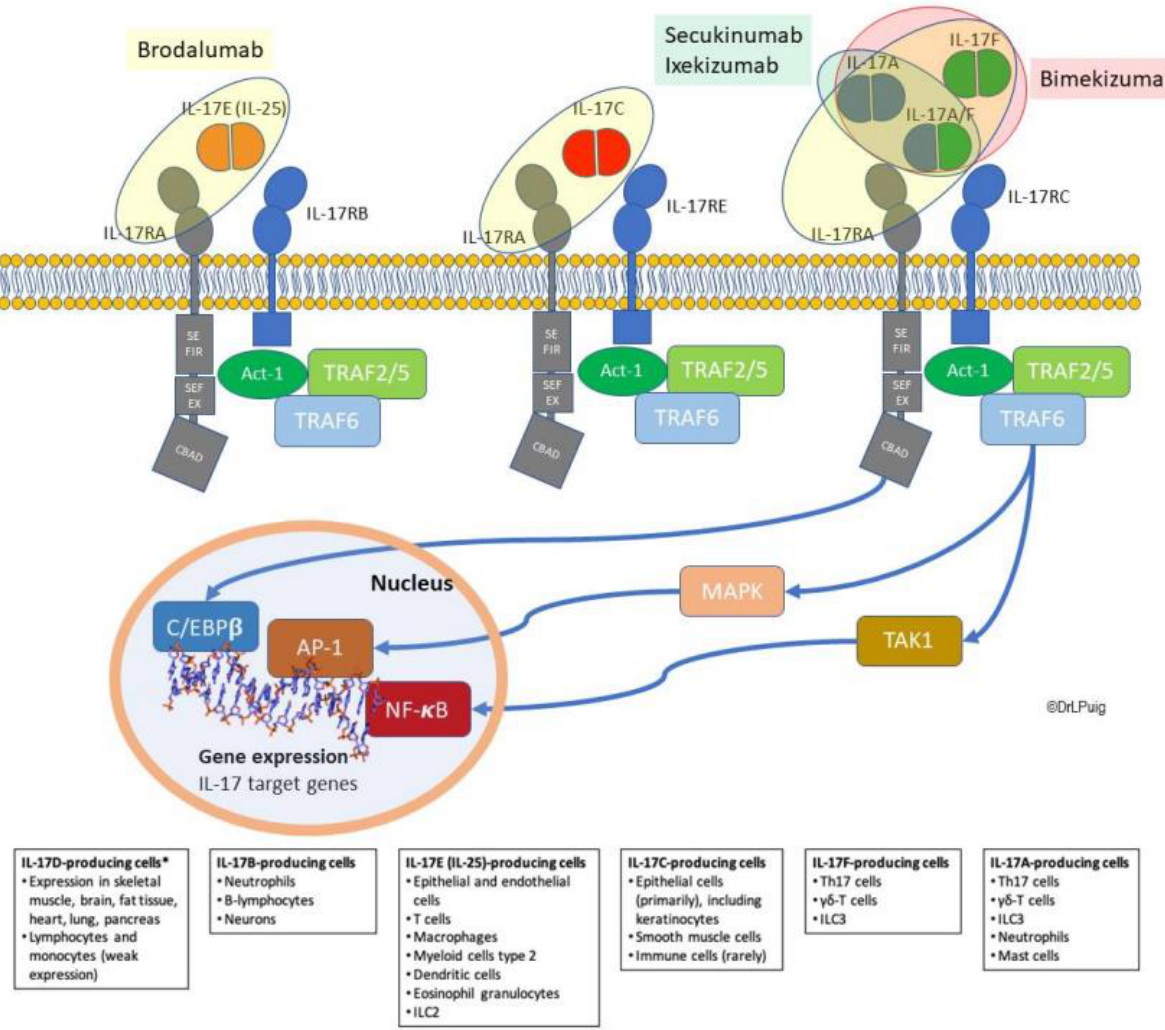
Figure 1. IL-17 family and treatments acting on the IL-17 pathway. Illustration of the different IL-17 ligands and receptors, and scheme of the intracellular signaling cascade (using an example of the activation of the IL-17A receptor). * IL-17D is not represented as its receptor remains unidentified; neither is IL-17B for the sake of simplicity. SEFIR: SEF/IL-17 receptor; SEFEX: SEFIR extension; CBAD: C/EBPß activation domain; and TRAF: TNF-receptor associated factor. Circles mean the blocking target of each therapy: those within yellow circles blocked by Brodalumab, those within green circle blocked by Secukinumab and Ixekizumab and those within pink circle blocked by Bimekizumab. This illustration has been elaborated from information available in references